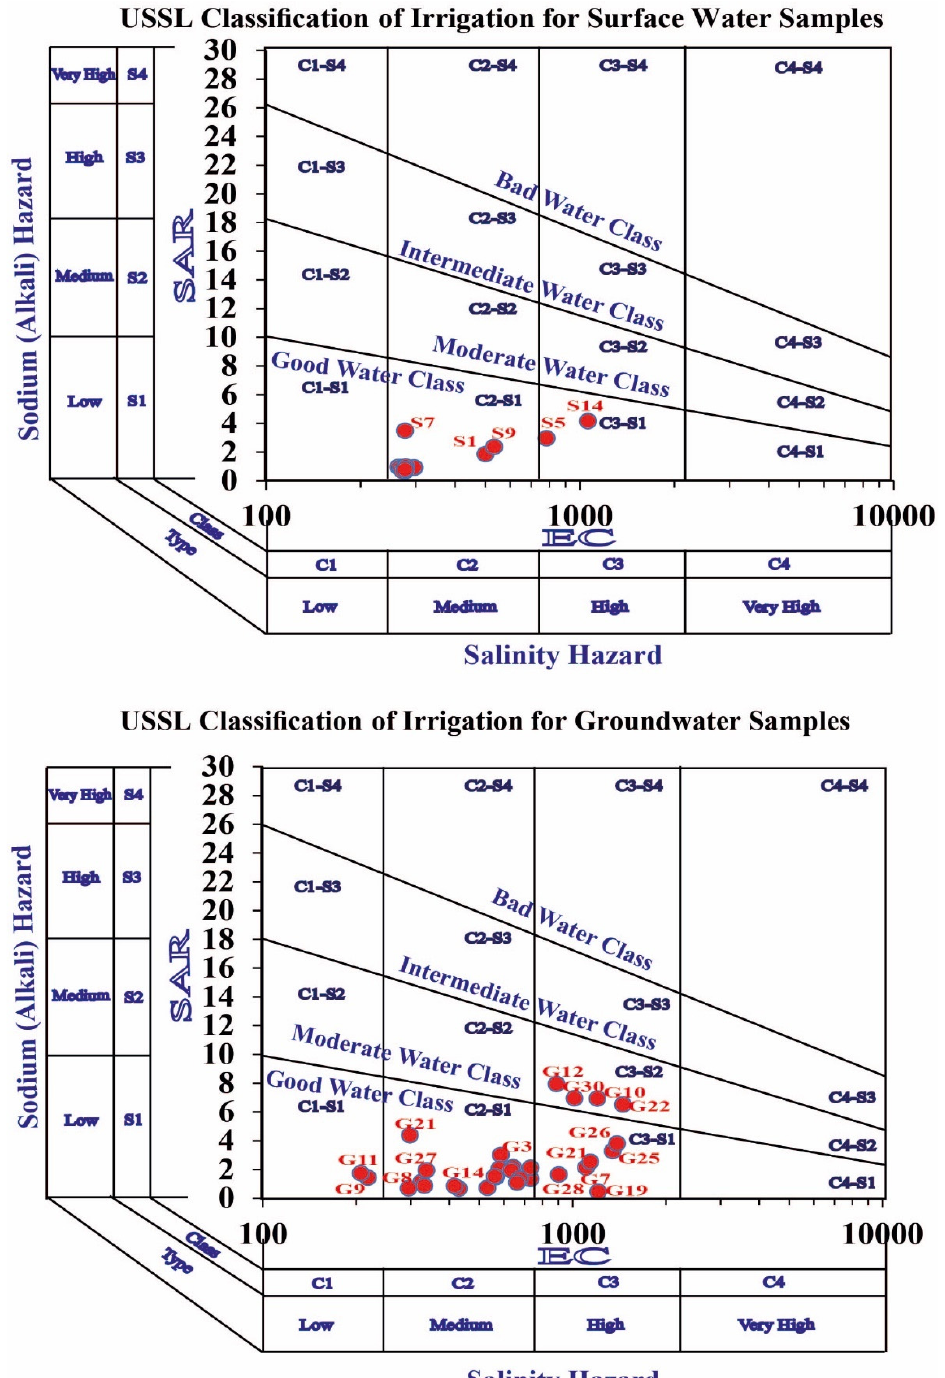
Figure 6. USSL diagram for classi fi cation of irrigation waters